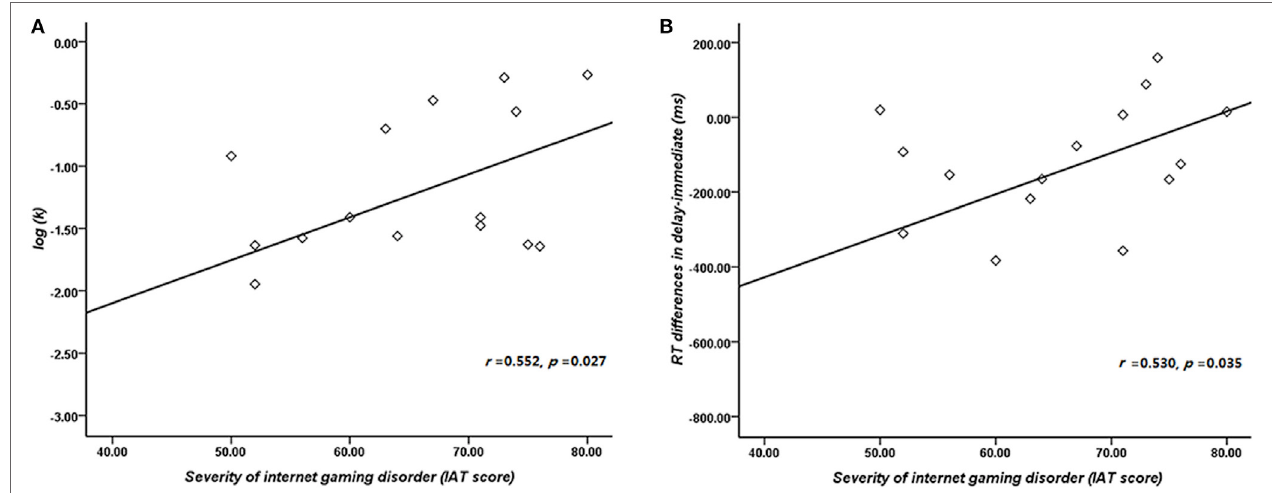
FigUre 3 | Correlation between the severity of Internet gaming disorder (IGD) and behavioral performance. (a) Correlation between the severity of IGD and log k. (b) Correlation between the severity of IGD and reaction time (delay − immediate). (Scores greater than 3 SDs were regarded as outliers and were excluded from further